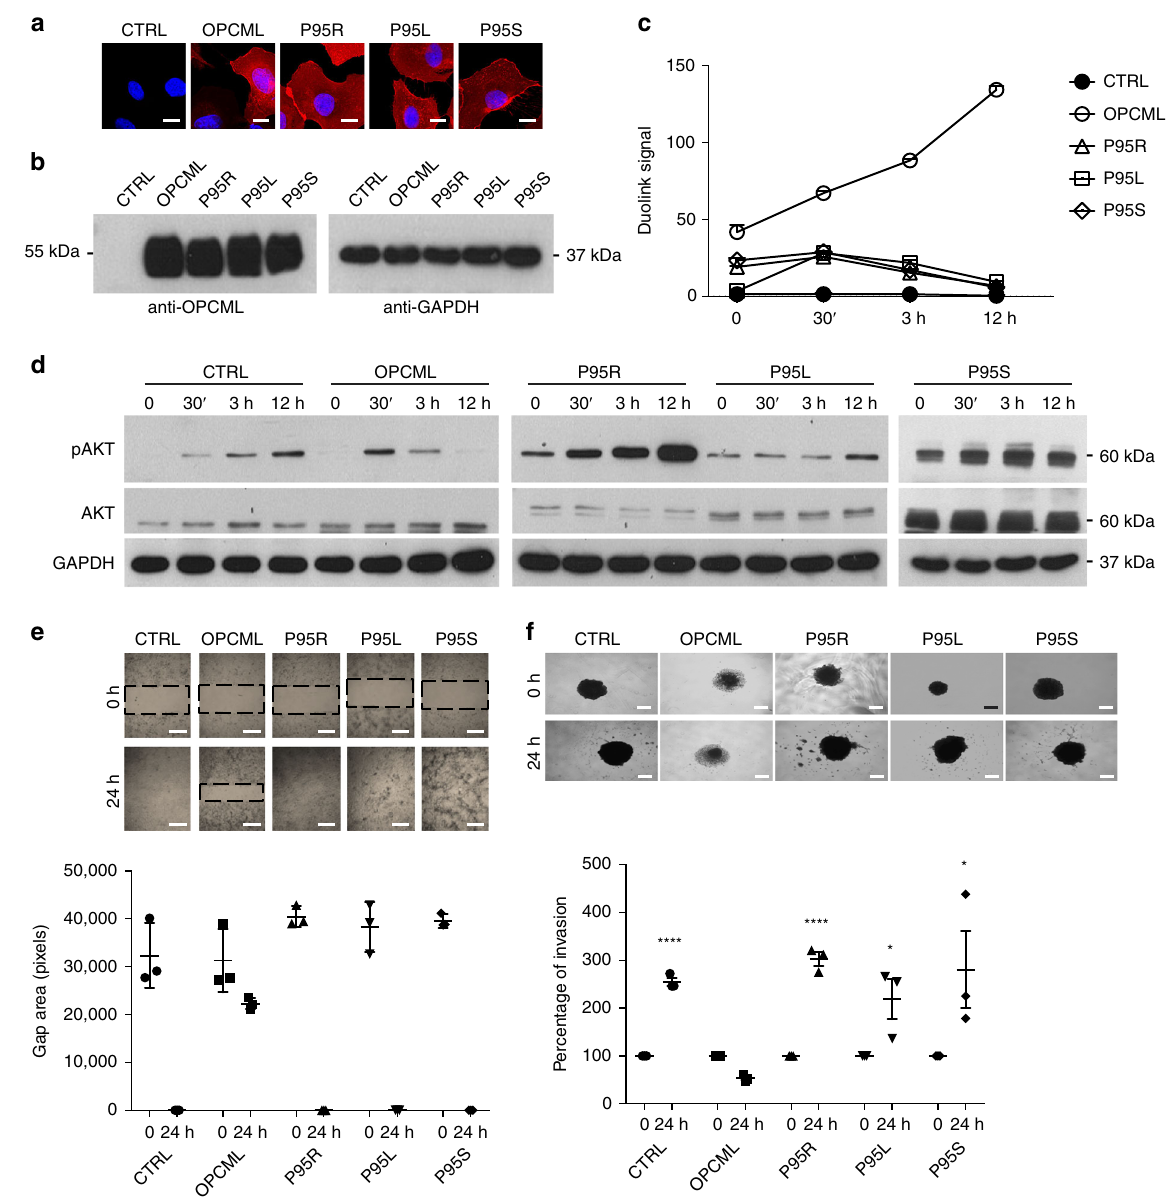
Fig. 5 Mutations at P95 show similar loss of tumor suppressor function and AXL interaction. SKOV3 cells were transduced with an empty vector (CTRL), wild- type (OPCML) or mutant (P95R, P95L, P95S) OPCML and analyzed for protein expression/localization by confocal microscopy ( a ) and protein expression